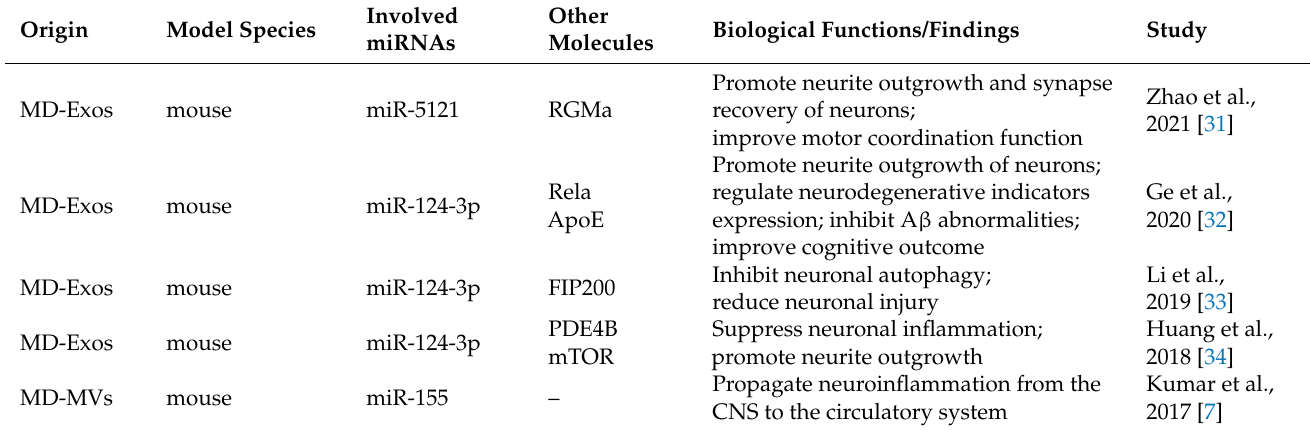
Table 1. Microglia-derived Exos/MVs and MD-Exos/MVs-miRNAs studies in